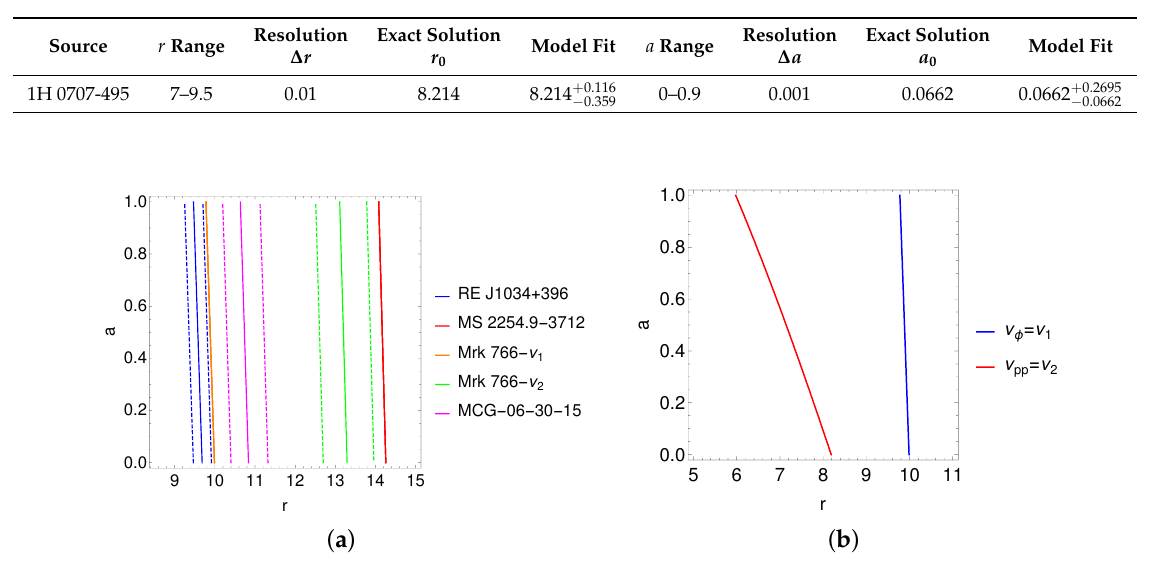
Table 3. The table summarizes results of { r , a } parameter solution, and corresponding errors for X-ray QPOs in NLSy1 1H 0707-495. The columns provide the range of parameter volume taken for { r , a }, the chosen resolution to calculate the normalized probability density at each point inside the parameter volume, the exact solutions, and the results of the model fit to the integrated profiles. The mass of the black hole is fixed to M • = 5.2 × 10 6 M (cid:12)